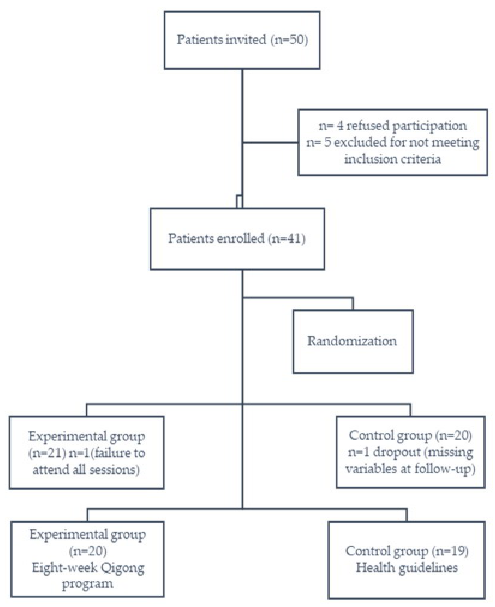
Figure 1. Flow of the